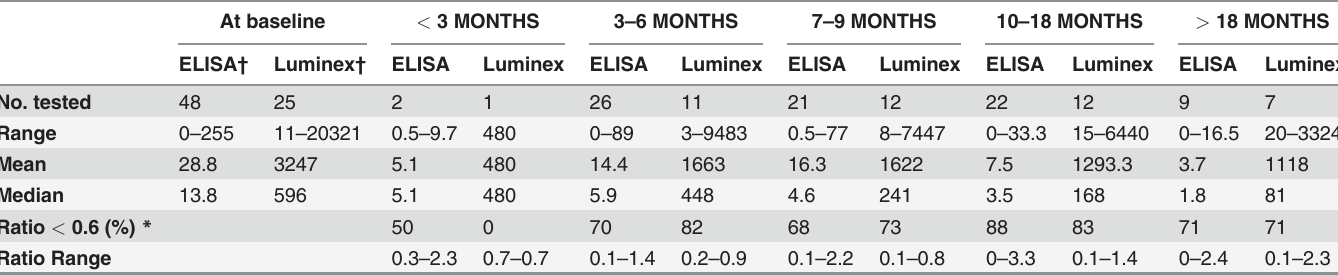
Table 3. Change in antibody response following